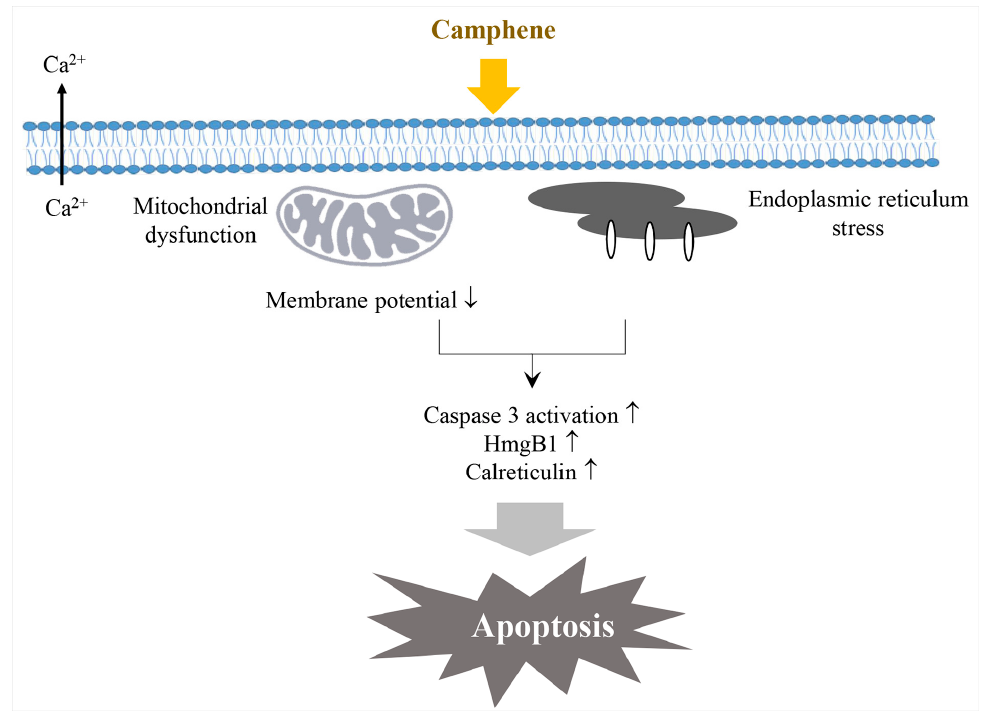
Figure 2. Diagram of apoptosis induction by camphene via mitochondrial dysfunction and endo- plasmic reticulum stress (modified from Girola et al. 2015 [22]). Camphene stimulates Ca 2+ efflux, downregulates membrane potential to induce mitochondrial dysfunction, induces endoplasmic reticulum stress, increases caspase 3 activation, HmgB2, and calreticulin, and finally results in apoptosis. ↑ : increasing; ↓ : decreasing.